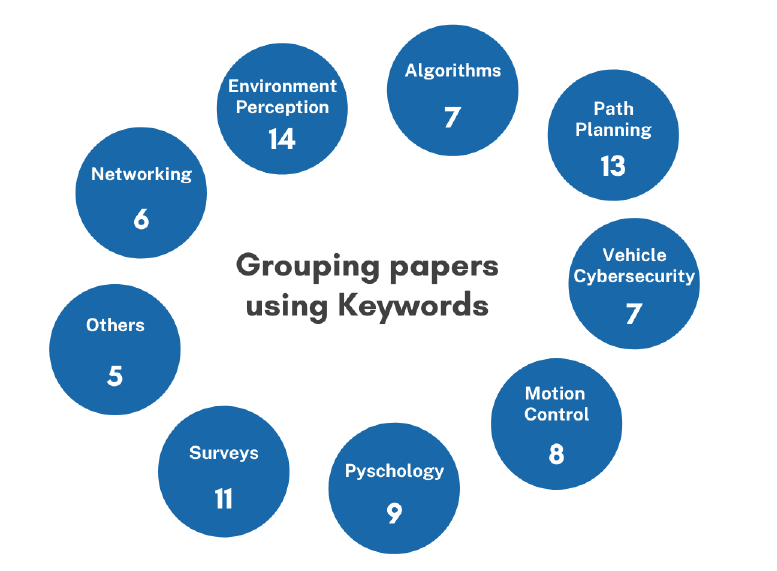
Figure 1 is a visual representation of classification according to domains.